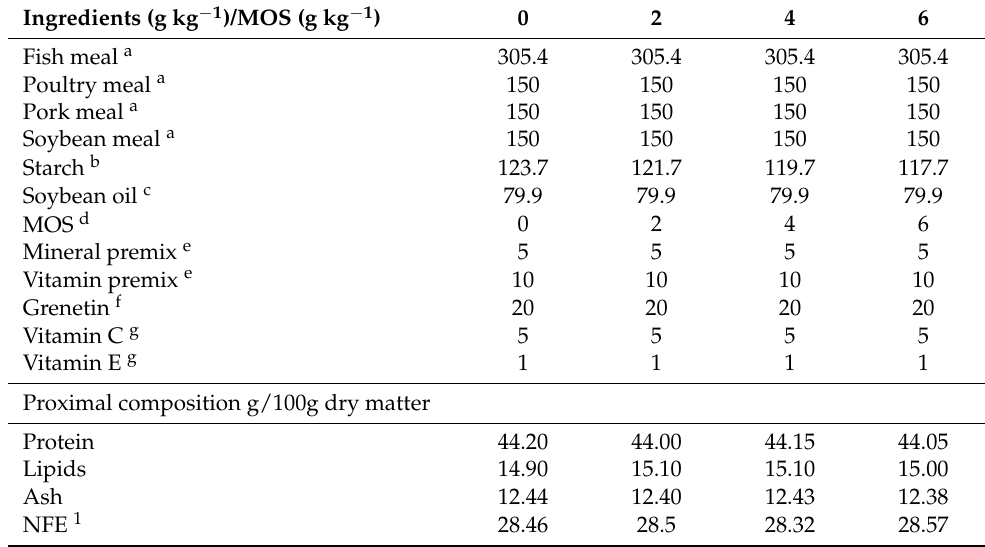
Table 1. Composition of the experimental